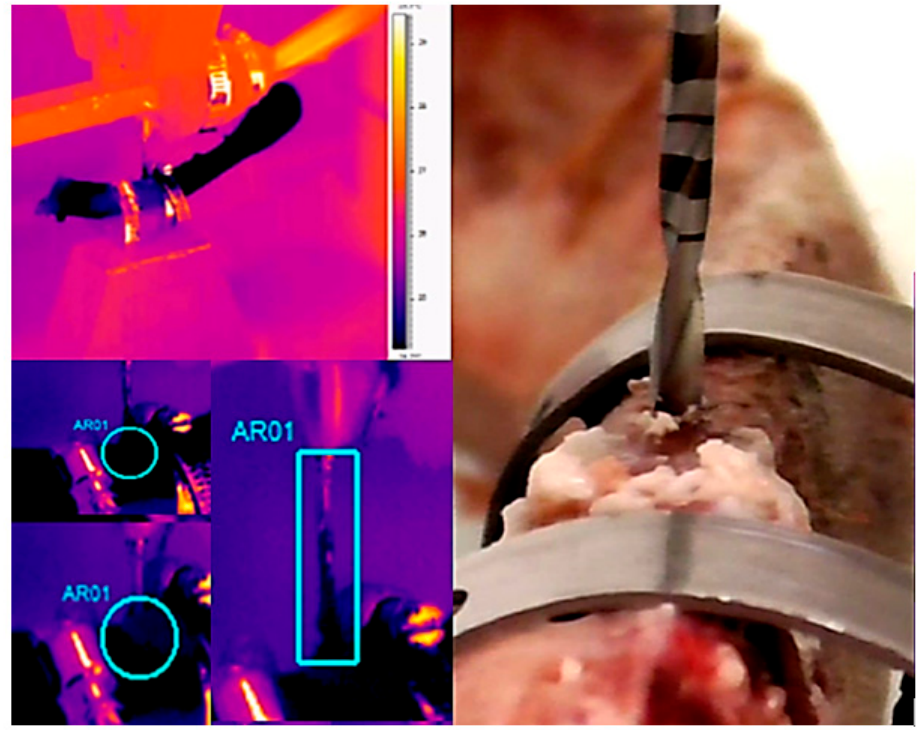
Figure 5. Infrared thermography temperature evaluation of the steel cylindrical drill (2